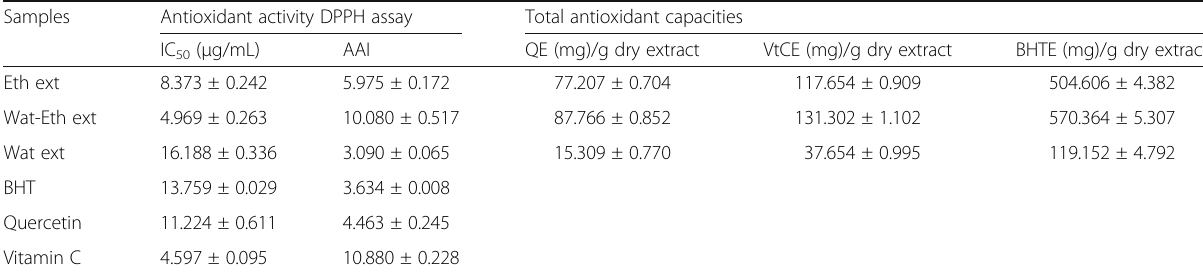
Table 6 Results of antioxidant activity of S. ochocoa extracts Samples